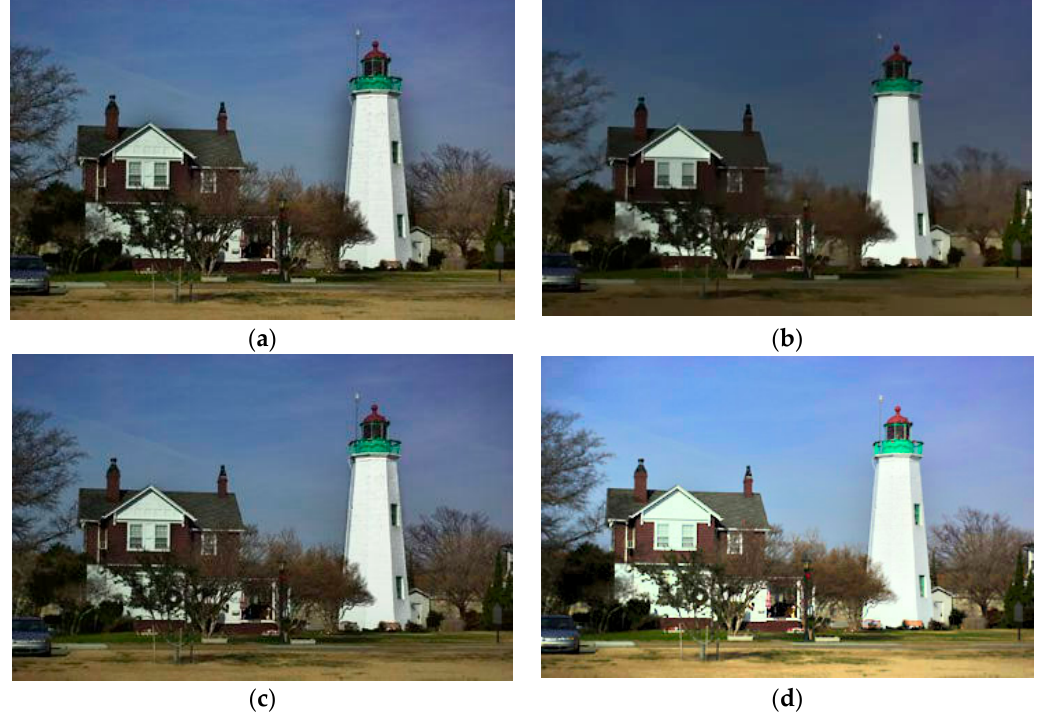
Figure 12. Reproduced degraded image (Figure 10b). ( a ) Ng’s model; ( b ) HoTVL1; ( c ) proposed model; ( d ) multiscale Retinex.